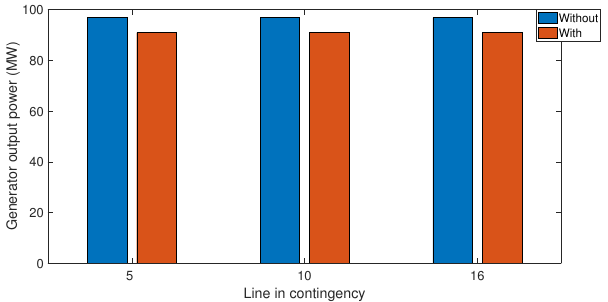
Figure 11. Power dispatch of renewable generator number 4 without and with loadability restrictions for every contingency applied (disconnection of branch).